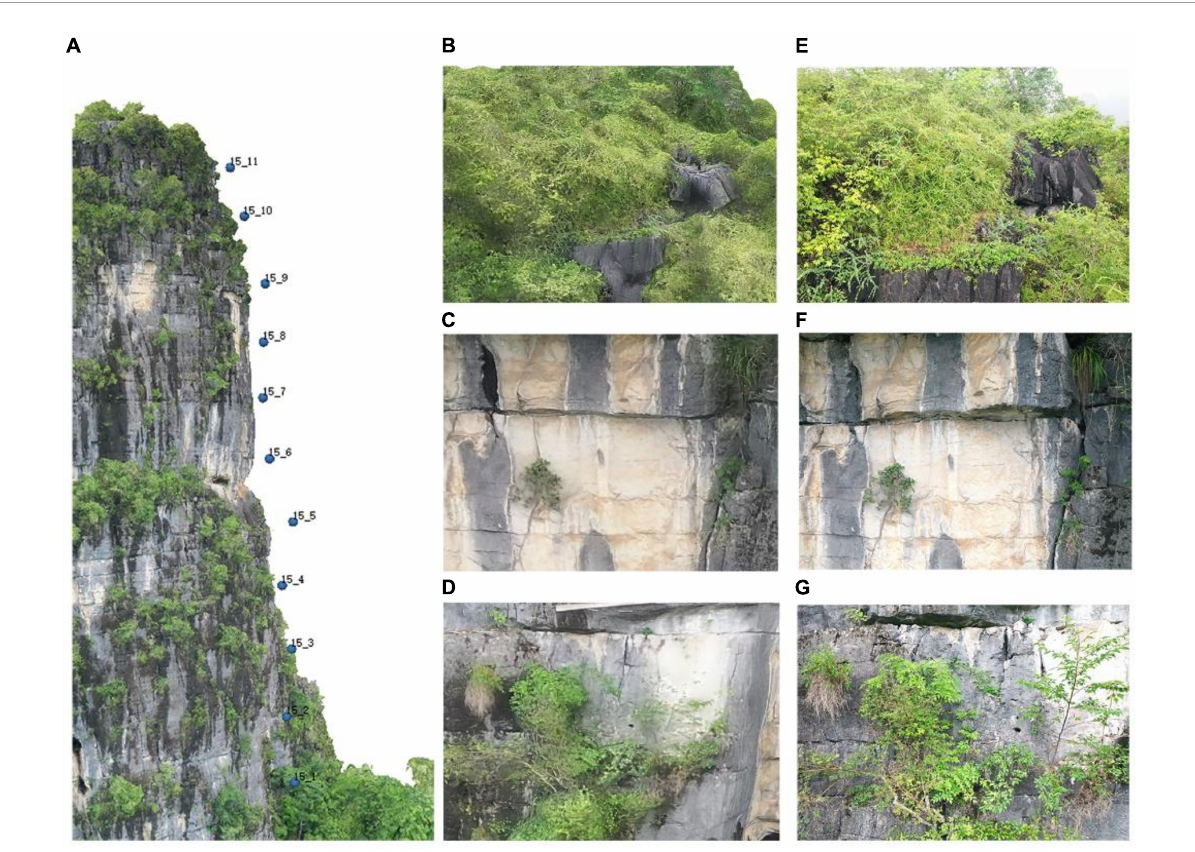
FIGURE7 (A) Close-range photogrammetry of the cliff. In the picture, a total of 11 photos were taken of the cliff face, and the interval height of each photo was 10 m. Cliff number and shot order of close-range photo were renamed. (B–D) The upper, middle, and lower parts of the cliff model. (E–G) The upper, middle, and lower parts of close-range